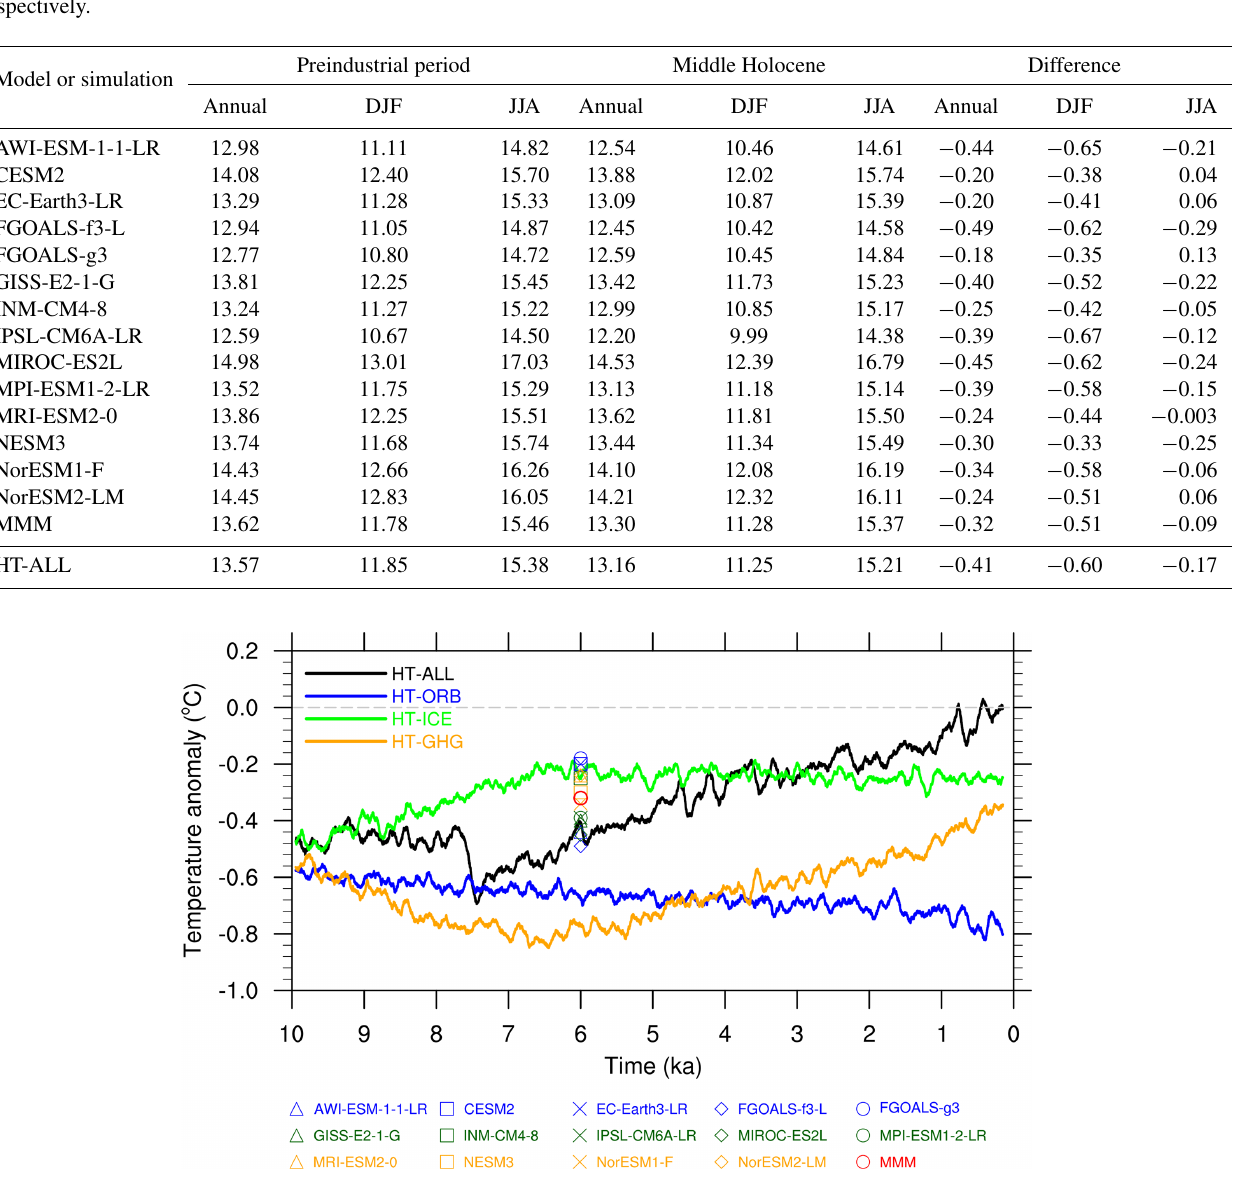
Figure 5. Global annual mean surface air temperature anomaly since 10ka under the all-forcing (HT-ALL – black) and the single-forcing (HT-ORB – blue; HT-ICE – green; HT-GHG – orange) simulations relative to the last 101 years of the all-forcing simulation. All of the time series are smoothed by a 101-year moving average. The triangle, square, cross, diamond, and circle symbols at 6ka stand for the Middle Holocene minus preindustrial results simulated by the 14 PMIP4 models and their multimodel arithmetic mean